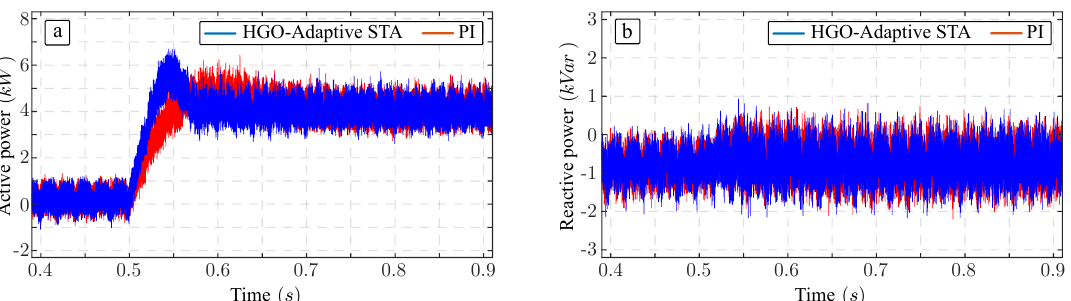
Figure 9. NPC active and reactive power dynamics under a 150 Ω load step. ( a ) Active power dynamics; ( b ) Reactive power